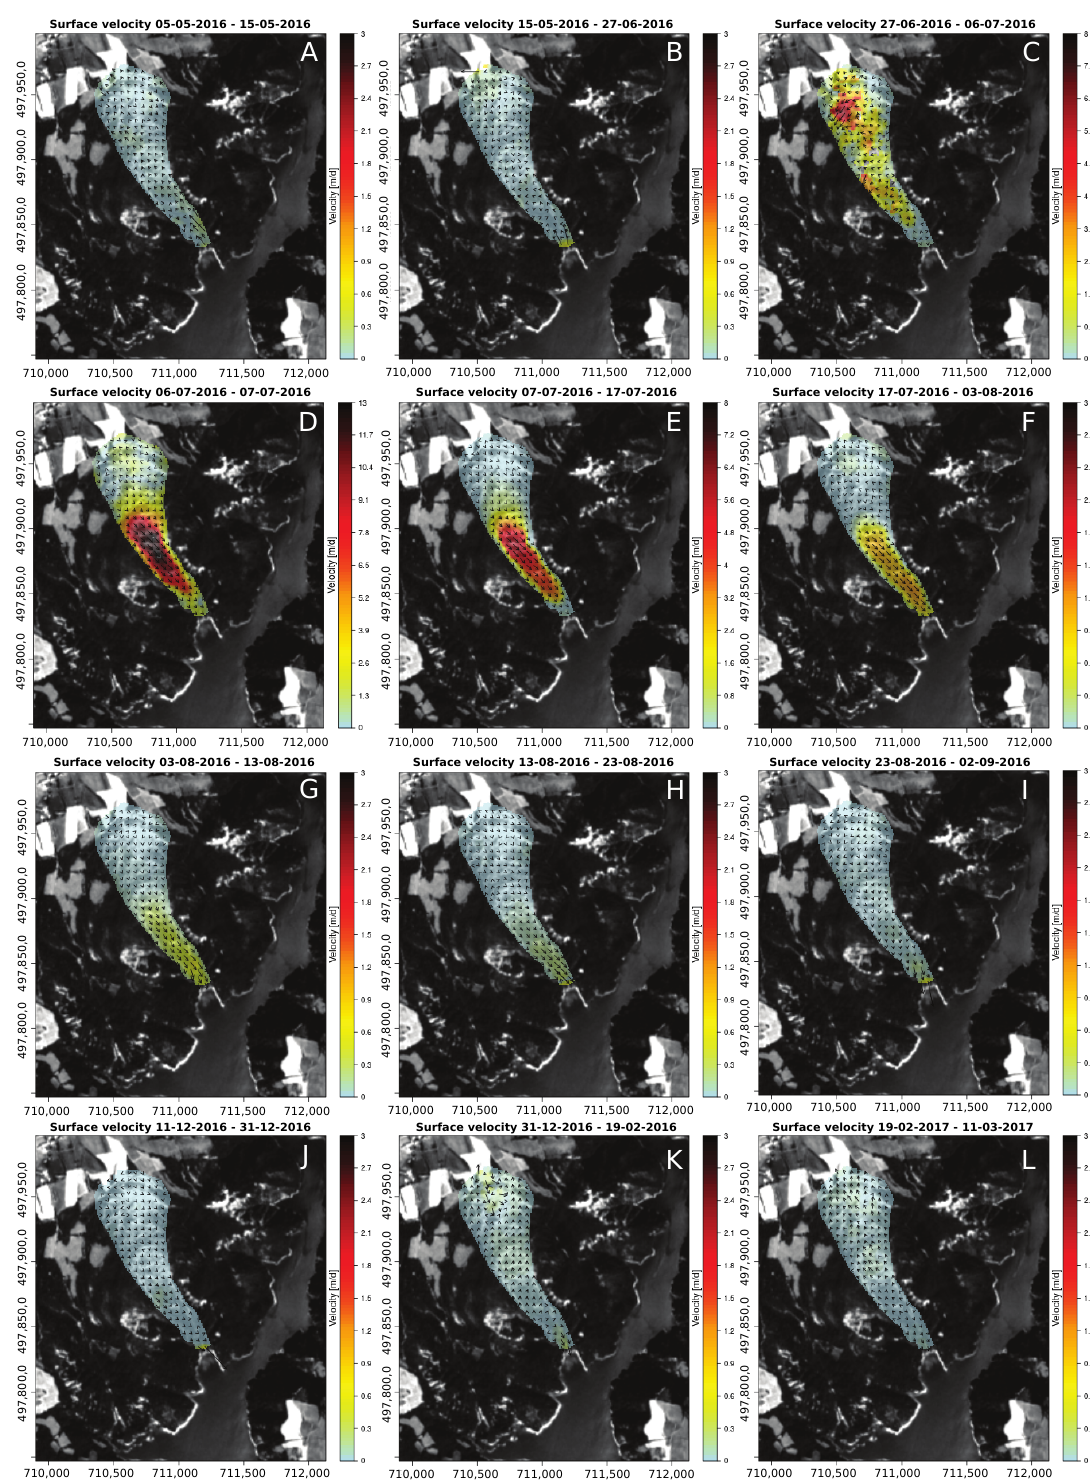
Figure 9. Subset of the time-series of horizontal surface displacement fields for the Harmalière landslide from 5 May 2016 to 2 September 2019 and 11 December 2016 to 11 March 2017. The plots A to I show the acceleration and deceleration associated to the main reactivation end of June 2016. The plots J to K depict the period 11 December 2016 to 11 March 2017 with a further activation of the head scarp on 29 January